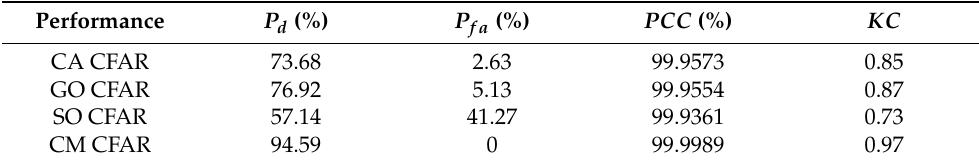
Table 3. Performance with quantitative